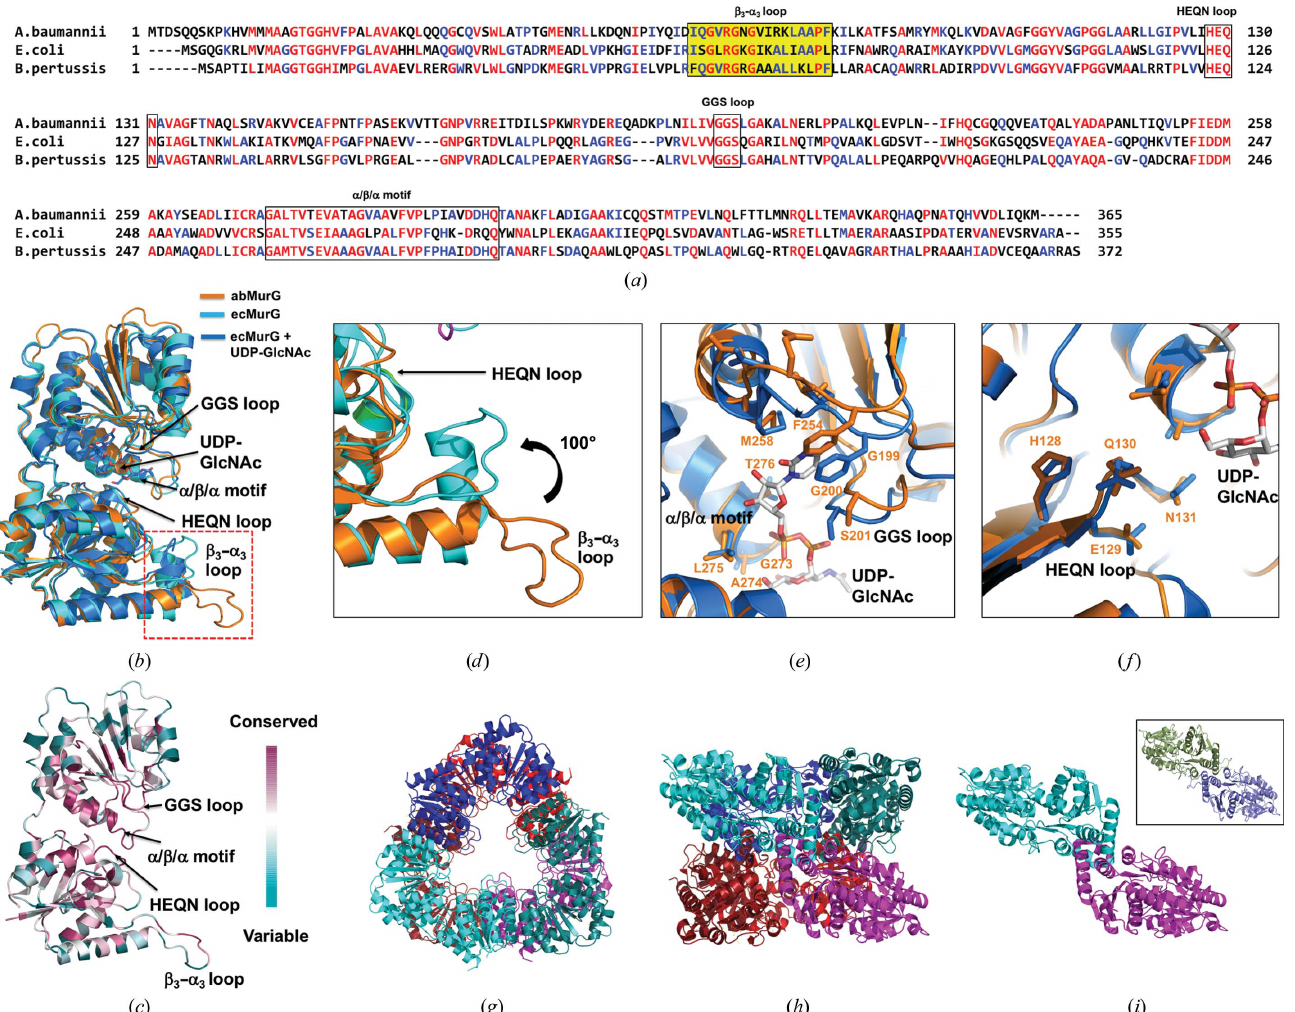
Figure 4 Structure and sequence comparison of abMurG and ecMurG. ( a ) Sequence alignment of MurGs from different species. Mostly conserved and partially conserved residues are shown in red and blue, respectively. The HEQN loop, GGS loop and (cid:3) / (cid:2) / (cid:3) motif are indicated with black boxes. The position of the (cid:2) 3– (cid:3) 3 loop is highlighted. ( b ) Structural superposition of abMurG (orange) with ecMurG (cyan) and the ecMurG–UDP–GlcNAc complex (blue). The red dotted box indicates the (cid:2) 3– (cid:3) 3 loop region. ( c ) Cartoon representation of abMurG colored according to the degree of amino-acid sequence conservation. The HEQN loop, GGS loop and (cid:3) / (cid:2) / (cid:3) motif regions, which are critical for the accommodation of substrates in the structure of abMurG, are indicated. ( d ) Different structural details of the (cid:2) 3– (cid:3) 3 loop region between abMurG (orange) and ecMurG (cyan). ( e ) Superimposition of the structure of abMurG with ecMurG focusing on the UDP–GlcNAc-binding site. ( f ) Superimposition of the structure of abMurG with ecMurG focusing on the HEQN loop. ( g , h ) Putative hexameric structure of ecMurG modeled using the hexameric abMurG structure as a template: top ( g ) and side ( h ) views. ( i ) Type 1 interaction between two molecules in the hexameric structure of ecMurG. The type 1 interaction in the hexameric structure of abMurG is shown in a black box for